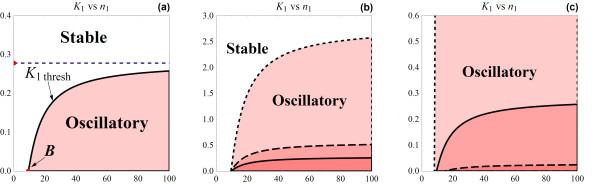
(a) Bifurcation diagram of K1 against n1. The stable and oscillatory regions are separated by the K1thesh curve which increasingly approaches the K1crit line (dashed). B, indicated on the n1-axis, is the minimum value of the Hill coefficient at which oscillations are possible (parameter values k1 = 1, k2 = 2, k3 = 1, kd1 = 1.2, kd2 = 3, kd3 = 2 were used for graphing). (b, c) Comparison of the K1 vs. n1 bifurcation diagrams for different scenarios. (b) K1 vs. n1 bifurcation diagram for the base parameter set, k1 = 1, k2 = 2, k3 = 1, kd1 = 1.2, kd2 = 3, kd3 = 2, (solid); when a synthesis rate k1 is doubled (dashed); and 10-times increased (dot). Note that the exact same effects are also obtained for changing other synthesis rates. (c) K1 vs. n1 bifurcation diagram for the base parameter set (solid) compared to the set in which the degradation rate kd1 is increased 10 times (dashed), and the set when the degradation rates are set identical, kd1 = kd2 = kd3 = 0.5 (dot).